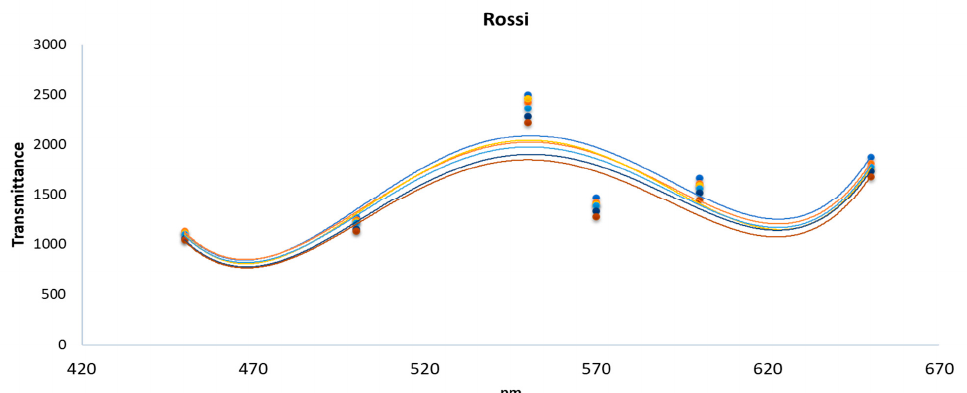
Figure 4. Visible spectra showing the average of transmittance ( n = 3) in tubers of S. tuberosum varieties (Agria, Picasso and Rossi), at harvest ● Control, ● 0.5 kg ha − 1 Ca(NO 3 ) 2 , ● 2 kg ha − 1 Ca(NO 3 ) 2 , ● 4 kg ha − 1 Ca(NO 3 ) 2 , ● 3 kg ha − 1 CaCl 2 and ● 6 kg ha − 1 CaCl 2 ).